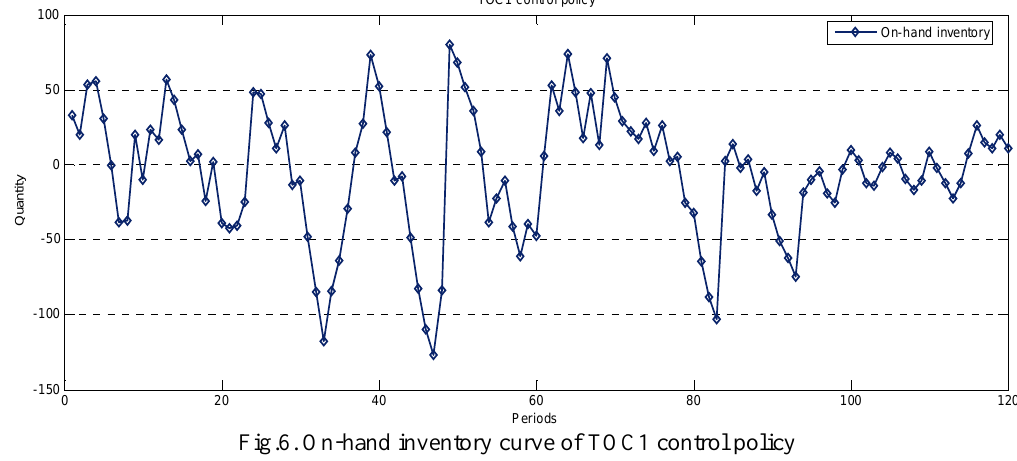
Fig.6. On-hand inventory curve of TOC1 control policy